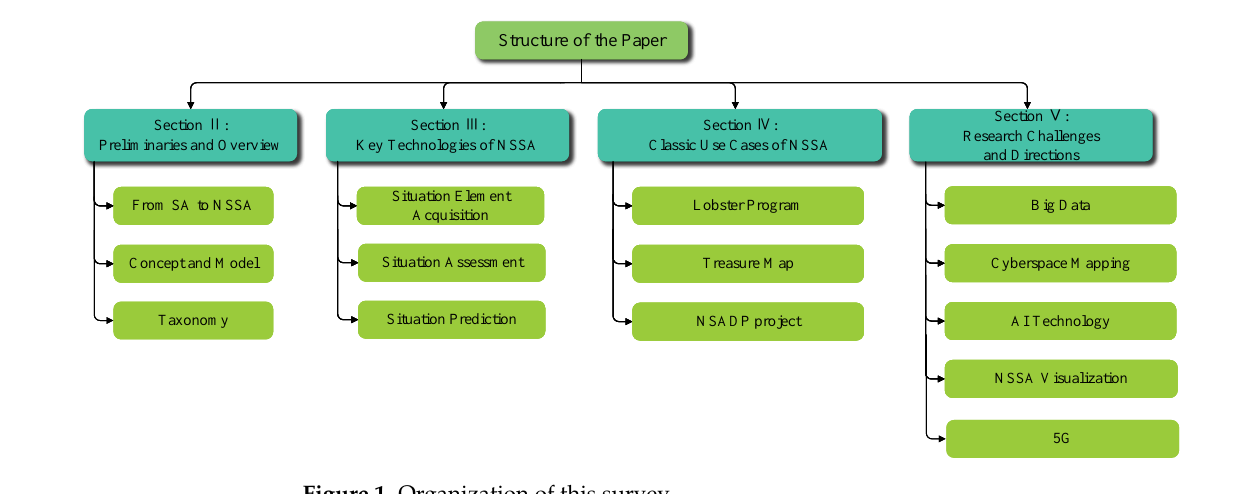
Figure 1. Organization of this survey. Table 1. Existing surveys on NSSA topics and our new